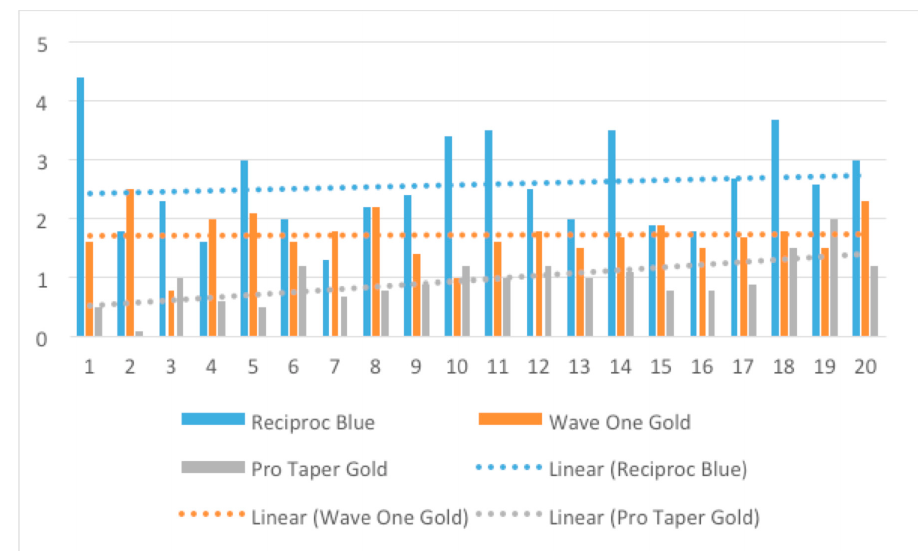
Figure 5. Values and trend line of canal curvature angle after shaping with WaveOne Gold, Reciproc Blue, and ProTaper Gold.